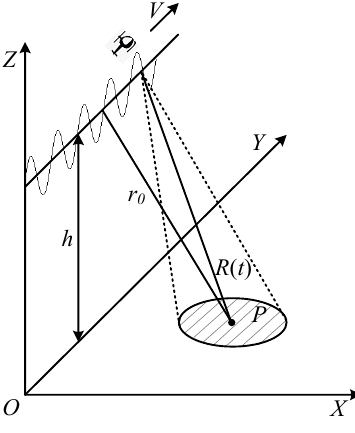
Figure 1. Imaging geometry of THz-SAR.